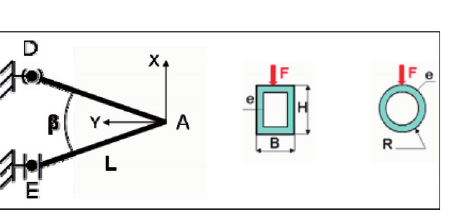
Fig. 6. Technical parameters scheme.